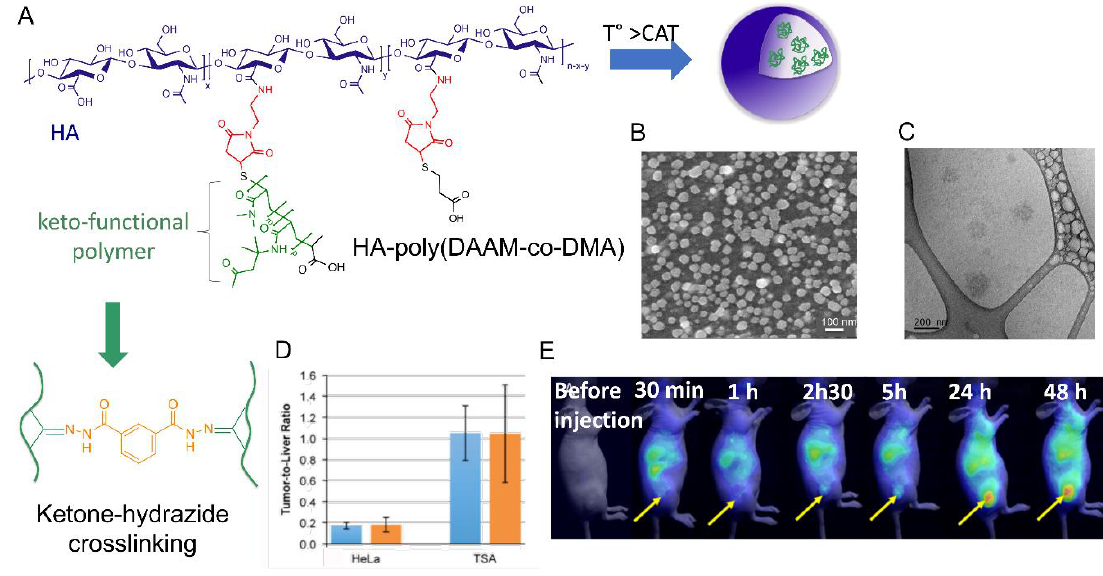
Figure 6. ( A ) Formation of hyaluronic acid-based nanogels by temperature-induced self-assembly and their covalent crosslinking by hydrazone bond formation within the hydrophobic domains of the grafted copolymer chains Morphology of HA-based nanogels crosslinked with an IDH:ketone molar ratio of 0.5 observed at 5 °C by TEM ( B ) and by cryo-TEM ( C ). ( D ) In vivo near-infrared Fuorescence (NIRF) images of the time dependent biodistribution of Cy5.5-labeled crosslinked nanogels in breast TS/A-pc and HeLa tumor-bearing mice. The tumor was engrafted subcutaneously on the right flank of the mouse. The fluorescence was measured before injection and at the following time elapse after administration: 30 min, 1h, 2 h 30, 5 h, 24 h, and 48 h. The tumor locations are indicated by the arrows. ( E ) Fluorescence intensity ratio of the excised tumor to liver at 24 h (blue) and 48 h (orange) post-injection. The results are expressed as the mean ± SD ( n = 3). Adapted with permission from [20]. Copyright 2019, Royal Society of Chemistry.